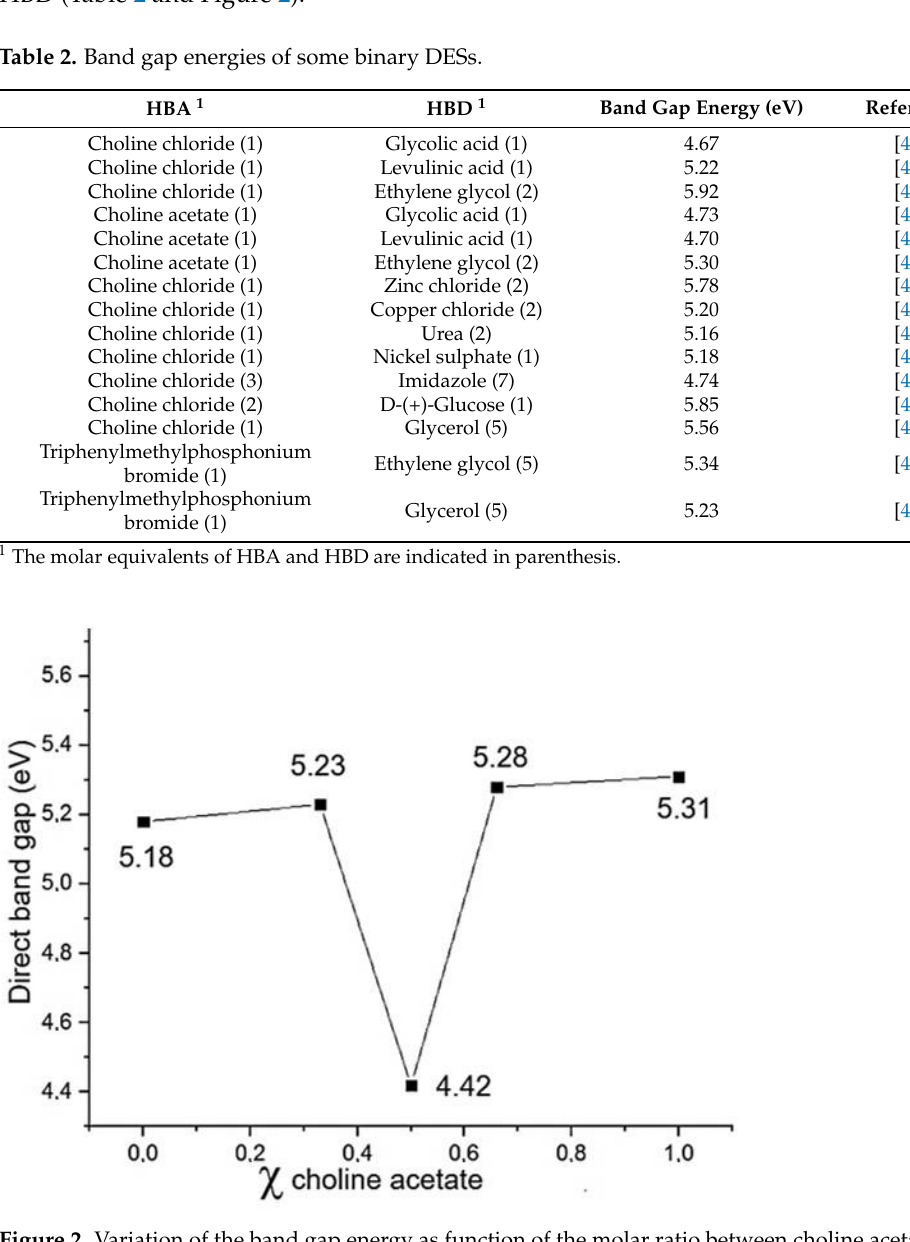
Figure 2. Variation of the band gap energy as function of the molar ratio between choline acetate and levulinic acid. Figure made from the data reported in reference